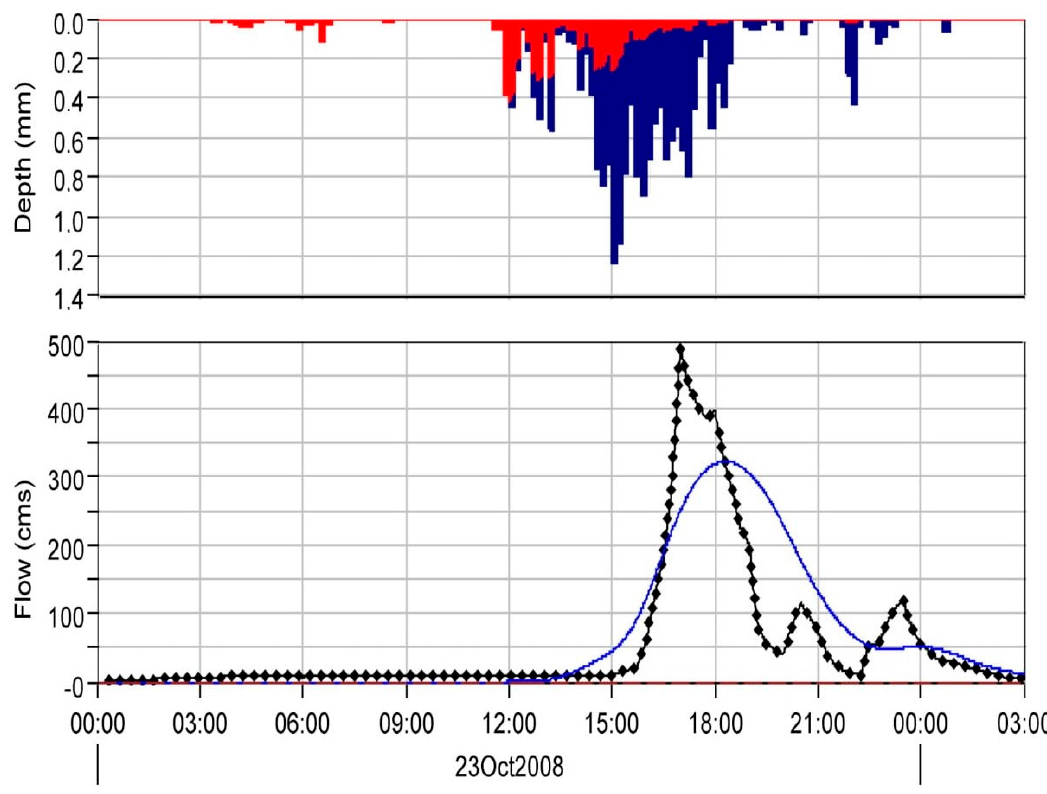
Figure 5. The simulated and observed hydrogram for the storm event on 23 October